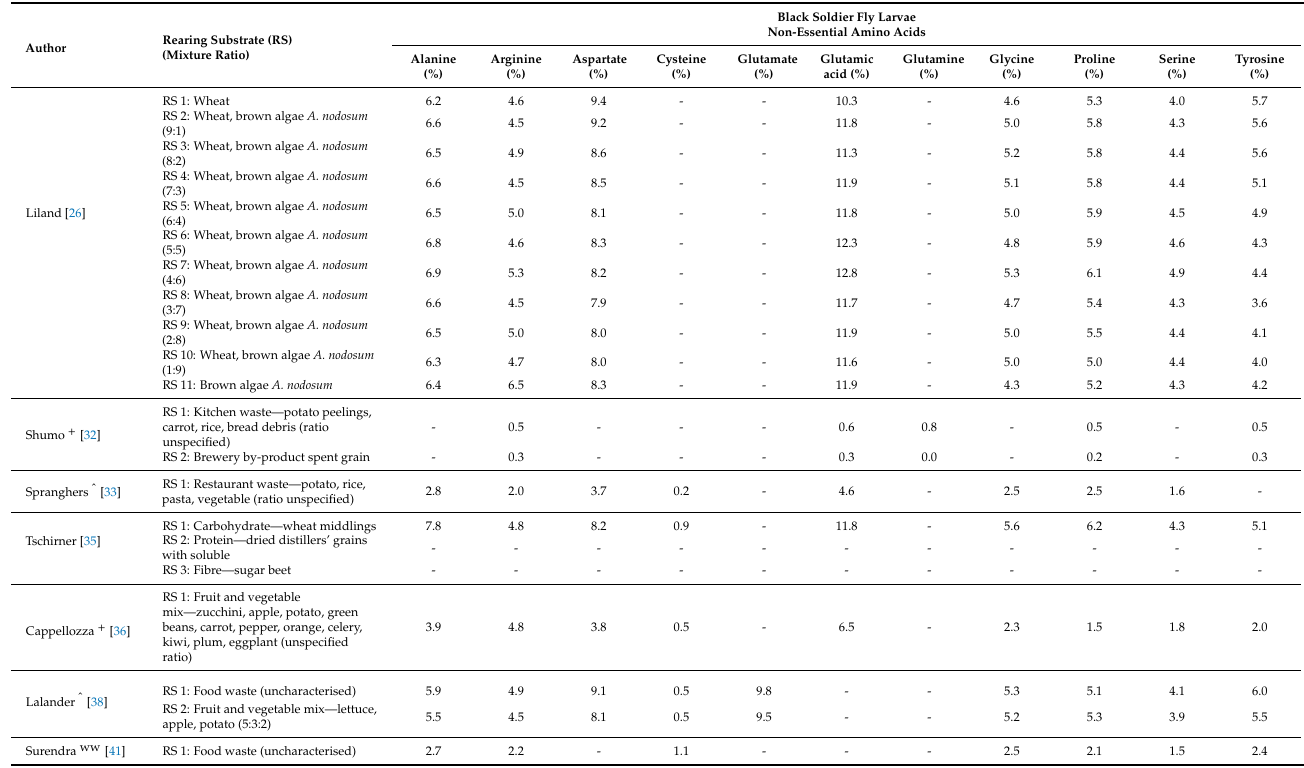
Table 5. Non-Essential Amino Acid Profile of Black Soldier Fly Larvae Reared on Food